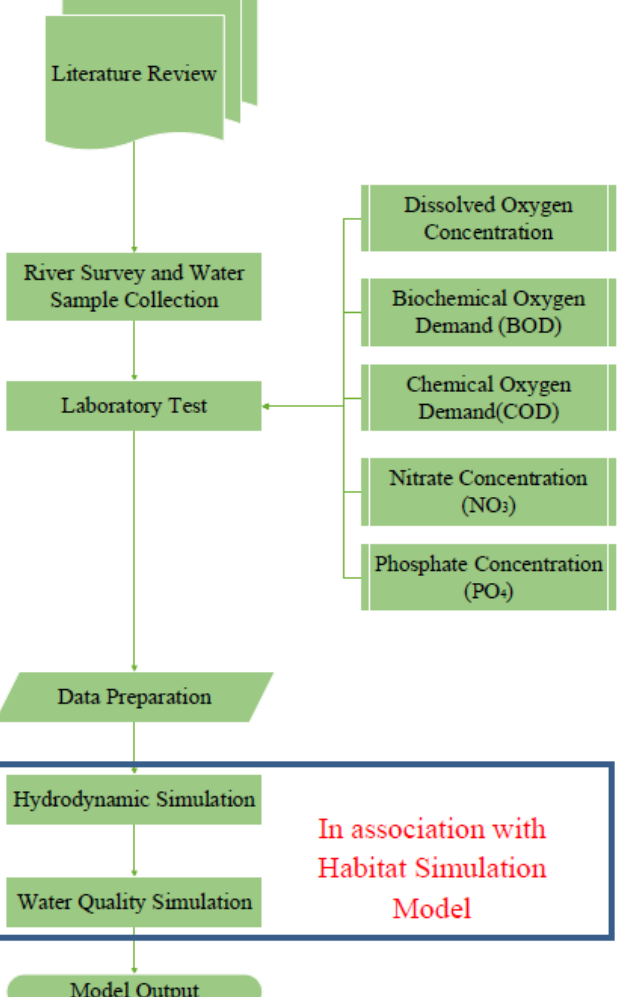
Figure 1. Adopted